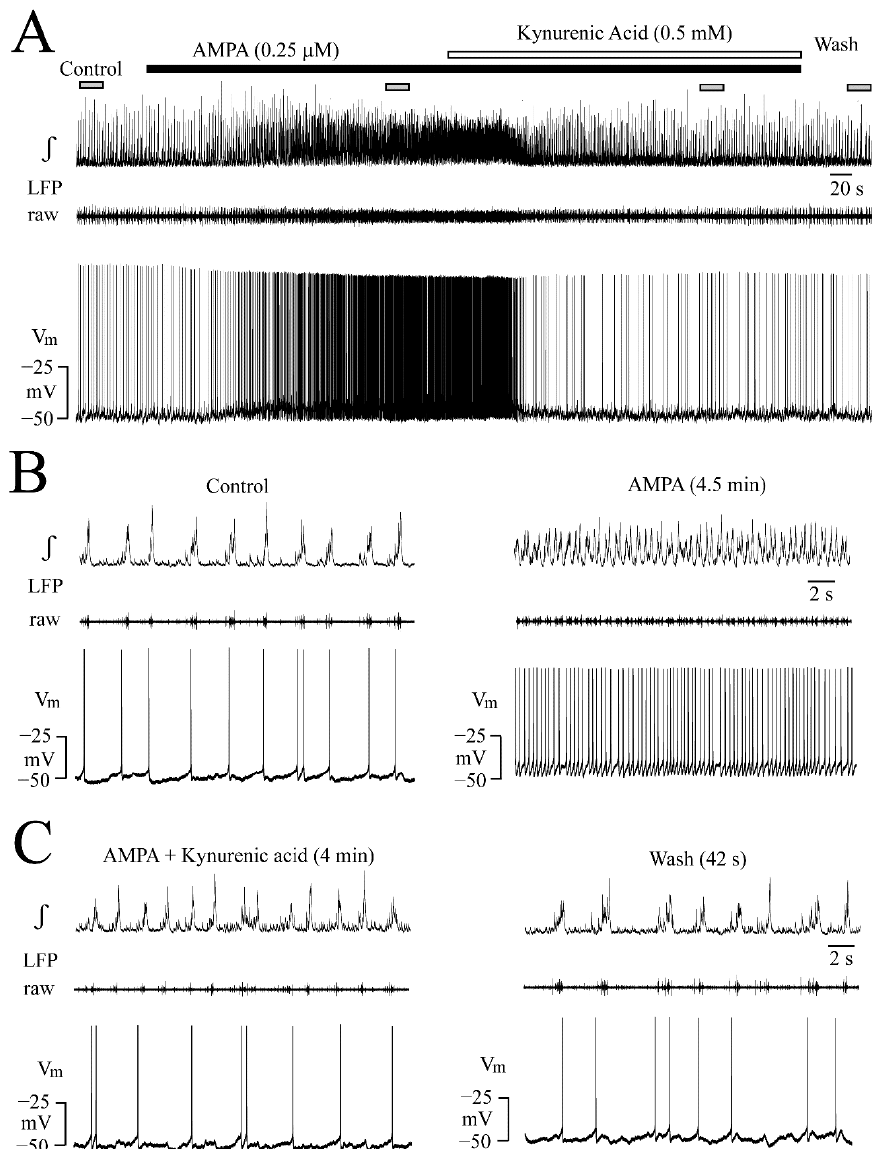
Figure 5. Effects of AMPA and the non-selective iGluR blocker kynurenic acid on LFP and neuronal membrane potential (V m ). ( A ) The continuous traces show that AMPA accelerated both the LFP (with concomitant pattern transformation) and neuronal spike discharge in association with a depolarization of ~5 mV and that kynurenic acid reversed these effects in the presence of AMPA. ( B , C ) The traces on an expanded time scale that were taken at the time periods indicated by the grey boxes in ( A ) show the effects of AMPA and their reversal by kynurenic acid in more detail.